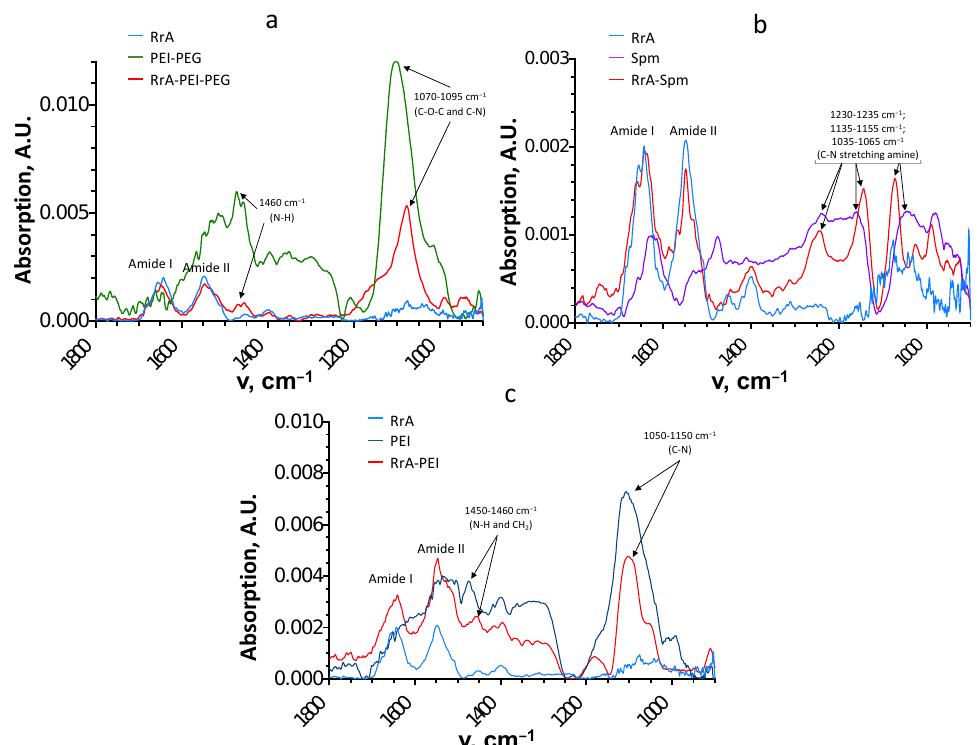
Figure 3. IR spectra of the native enzyme compared with conjugates: ( a ) RrA-PEI-PEG; ( b ) RrA-Spm; ( c ) RrA-PEI. The concentration of RrA was 1 mg/mL, PEI-PEG was 1 mg/mL, Spm was 0.5 mg/mL, and PEI was 0.1 mg/mL. Conditions: PBS 10 mM, 22 ◦ C.